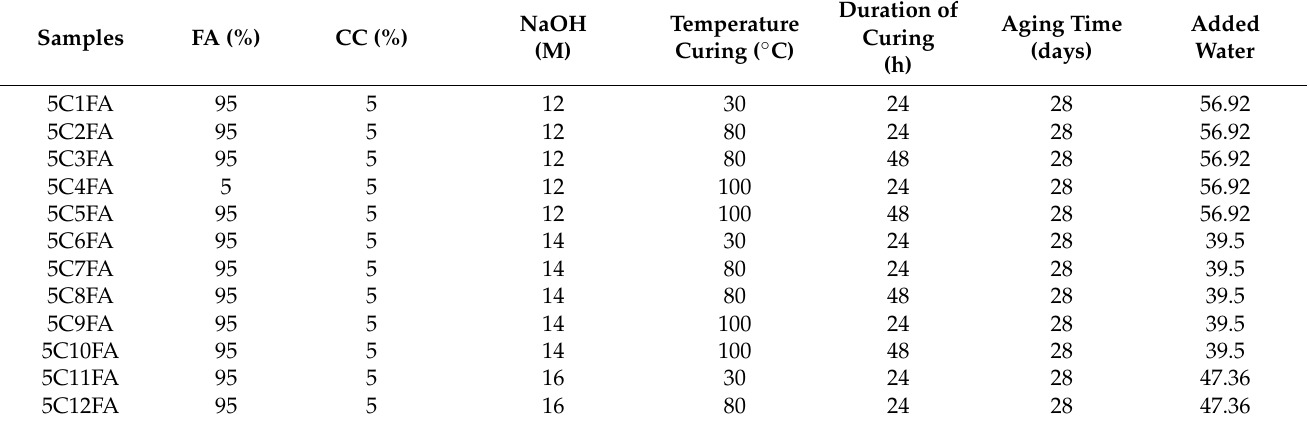
Table 5. Description of mix proportions for different FA–CC-based geopolymer concrete.